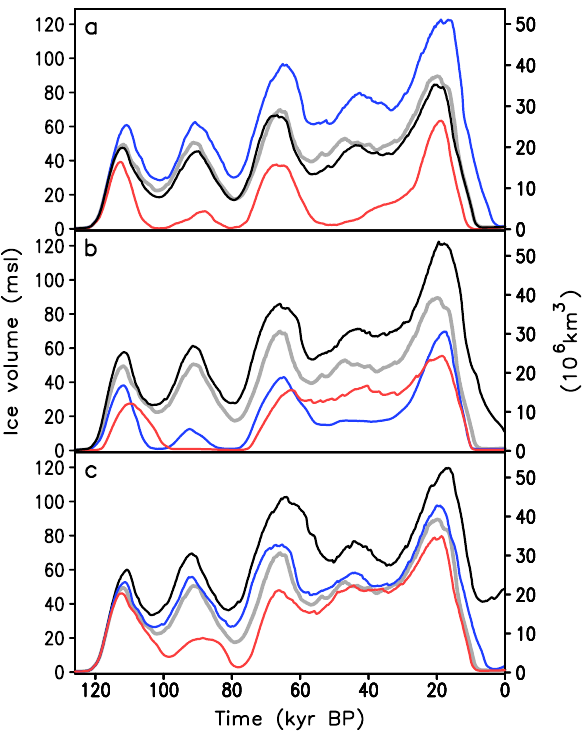
Fig. 11. Simulated NH ice volume in a suite of sensitivity exper- iments. Grey lines in all figures show the Baseline Experiment. (a) Sensitivity to ice-sheet-model parameterisations. The black line corresponds to the enhancement-factor value 12 (the value used in BE is 3), the blue line corresponds to the experiment without terres- trial sediments, the red line to the experiment where all land is cov- ered by terrestrial sediments. (b) Sensitivity to parameterisations of the surface energy and mass balance interface. The black line cor- responds to the experiment without parameterisation of elevation- desert effect, the blue line corresponds to the experiment without effect of elevation slope on precipitation, and the red line represents the experiment without the North American temperature dipole cor- rection. (c) Sensitivity to the effect of the glaciogenic dust deposi- tion. The black line represents the experiment without the effect of dust deposition on snow albedo, the blue line with a halved and the red line with doubled amounts of the glaciogenic dust